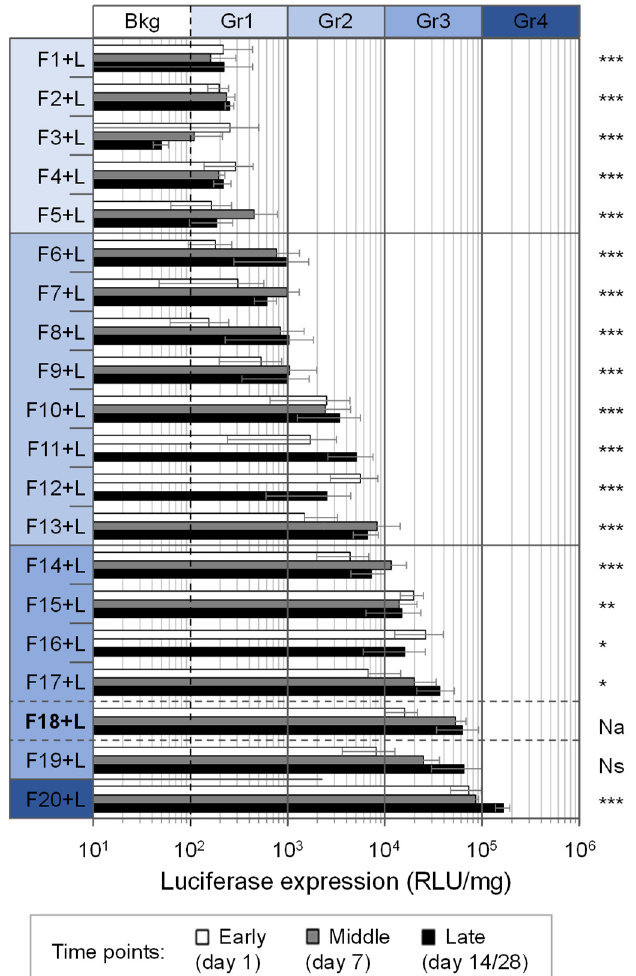
Figure 4. Luciferase activity in lung homogenates at three time points following aerosol treatment with various lipid + pGM144 formulations. Results correspond to means +/ − SD, with n = 5 mice/group i.e., at each time point. The dashed vertical line specifies the luminescence background (Bkg, as determined with naive mice, ~10 2 RLU/mg protein). Formulations are numbered from F1 to F20, according to the MLE (see Table 3 legend). Results for F11 + L, F12 + L, and F16 + L were not determined on day 7. The statistical significance determined when comparing the MLE of a given formulation with that of GL67A is indicated as follows: ***, p -value < 0.0005; **, p -value < 0.005; *, p -value < 0.05; Na, not applicable; Ns, non-significant.